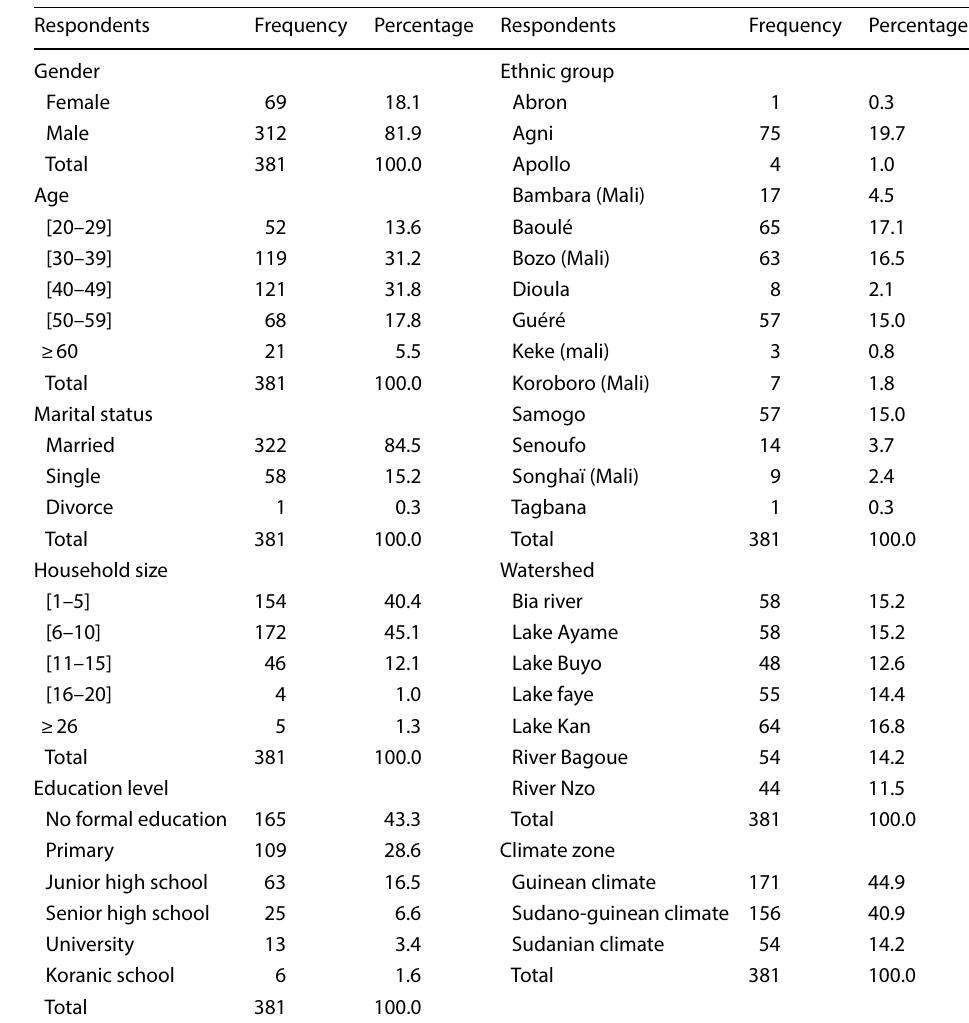
Table 1 Overview of the socio-demographic background of 381 respondents to